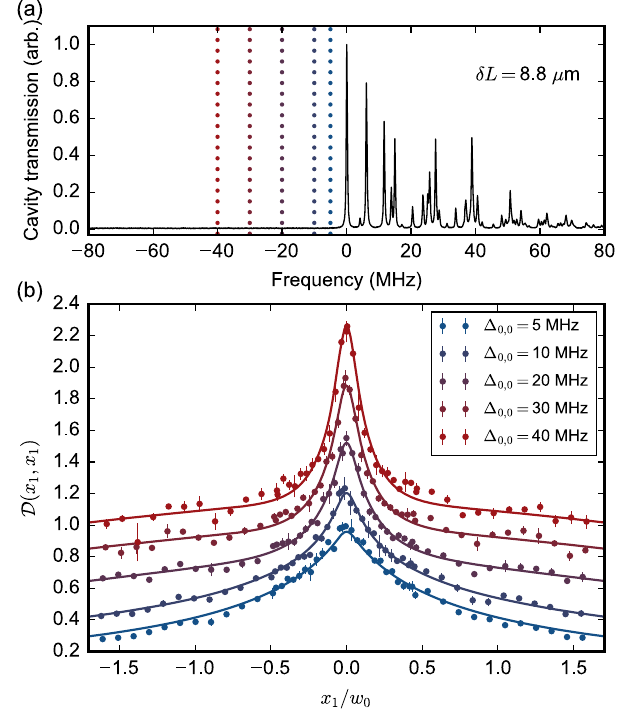
FIG. 3. Dimensionless interaction strengths versus position of a single BEC for various pump-cavity detunings Δ 0 the superradiant emission are similar to those in Fig. 4. (a) Trans- mission spectrum of the δ L ¼ 8 . 8 μ m cavity presented in Fig. 2(a). The dotted lines indicate the five values of Δ 0 the interaction energy of a single BEC was measured. The corresponding interaction energies are presented in (b). The solid lines are fits of Eq. (9) to our data and neglect the effect of astigmatism and spherical aberrations in our cavity spectrum. The error bars represent one standard error in the mean over three